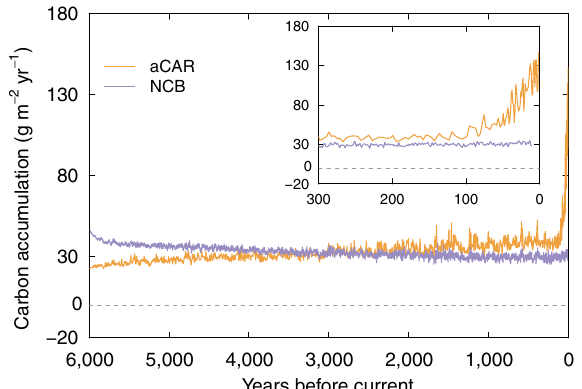
Figure 5. aCAR and NCB (20 year moving average) for the baseline simulation (see "Methods"). The aCAR values are for a virtual core taken from halfway down the modelled hillslope at the end of the simulation. NCB is calculated during each year of the simulation (i.e. at the time peat is gained or lost) and is akin to measuring C fluxes. The inset shows the typical ‘uptick’ of aCAR in recently-accumulated peat layers seen in many peat cores.